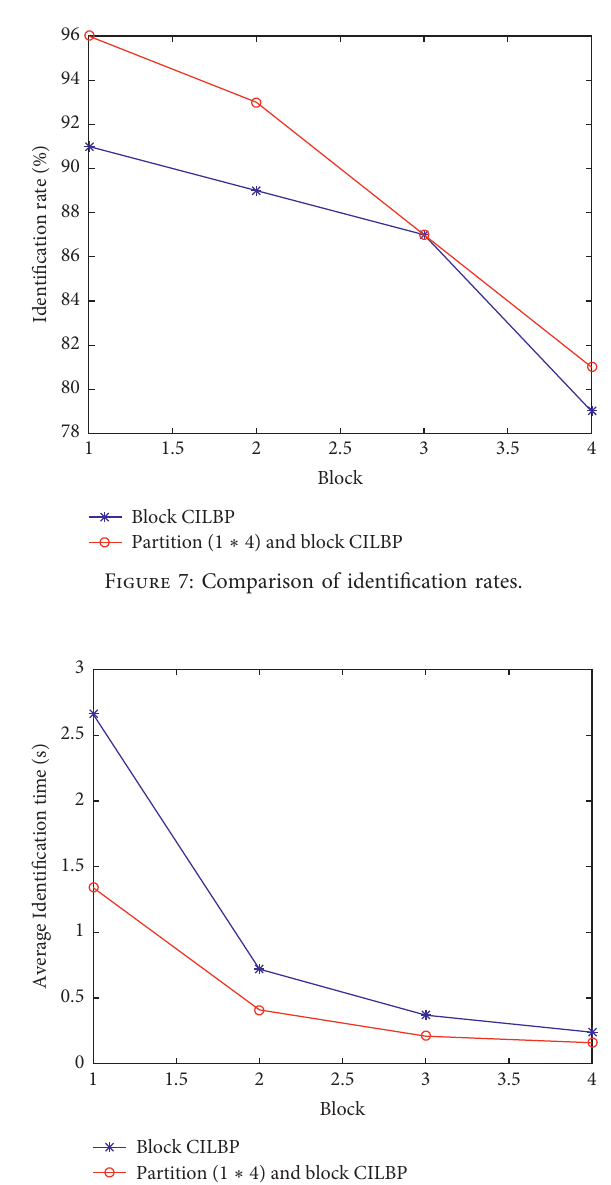
Figure 8: Comparison of average identification